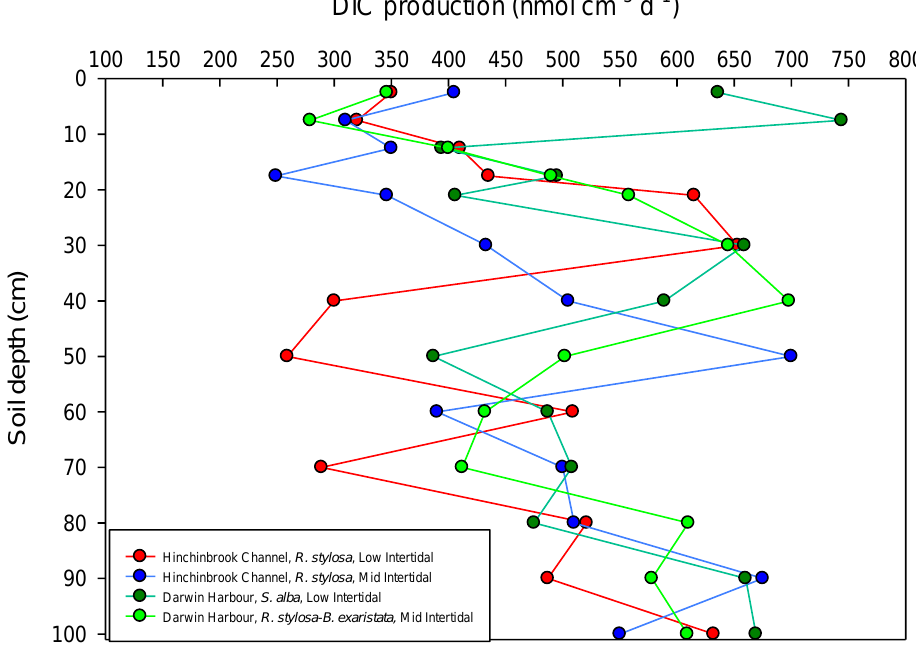
Figure 2. Vertical profiles of mean rates of DIC production at intervals to a soil depth of 1 m. Core samples and sample processing details were identical to the methods described in [54–63]. The mangroves at Hinchinbrook Channel, north Queensland, Australia, were sampled in June 2014, and the Darwin Harbour mangroves in the Northern Territory, Australia, were sampled in October 2014.